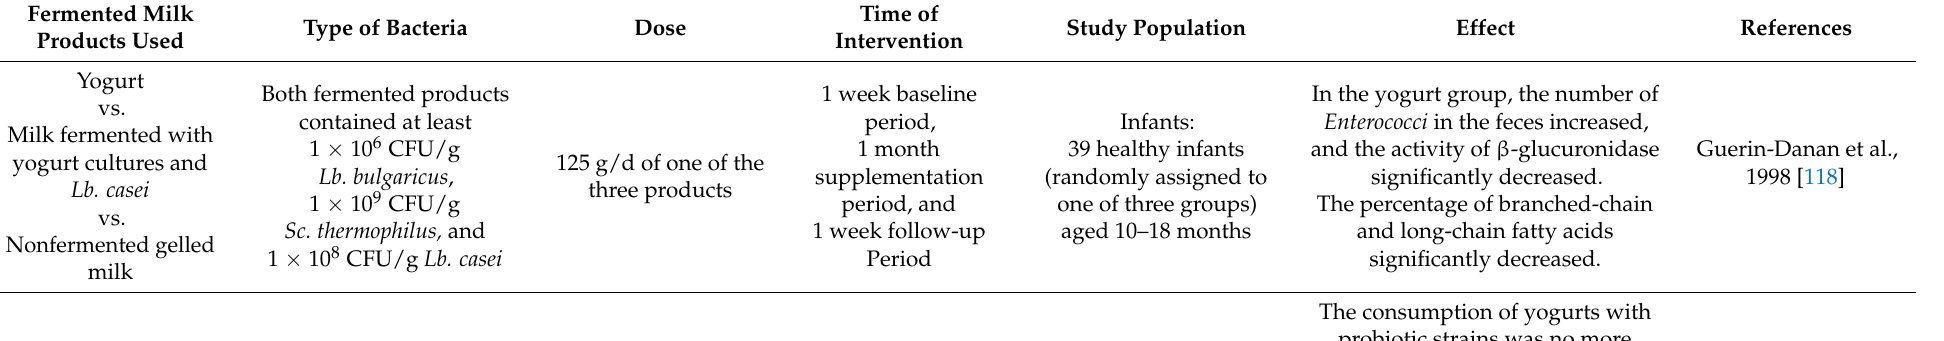
Table 3. The influence of fermented milk products on the microbiota composition in healthy